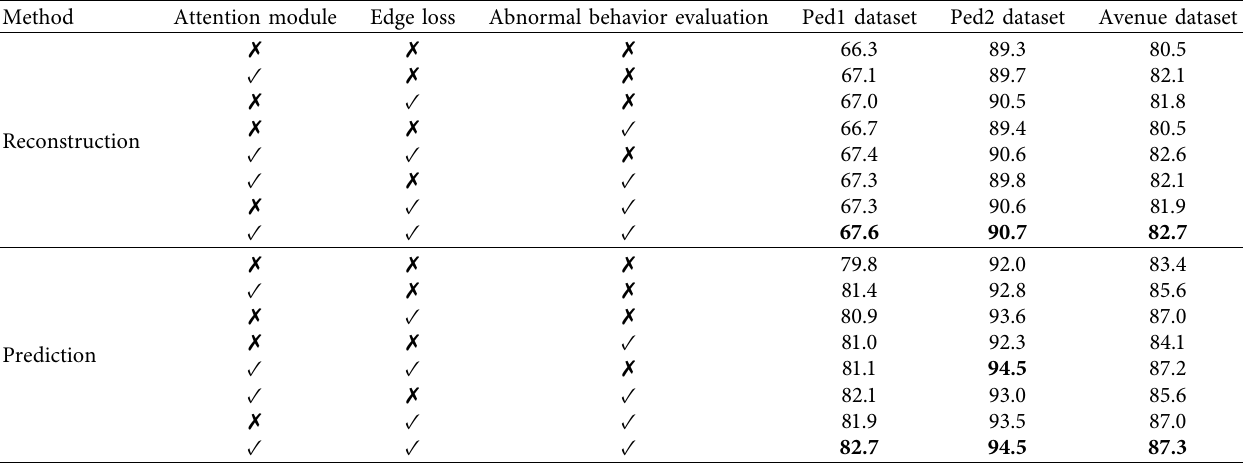
Table 2: Ablation experiments of attention-directed abnormal behavior detection model. Method Attention